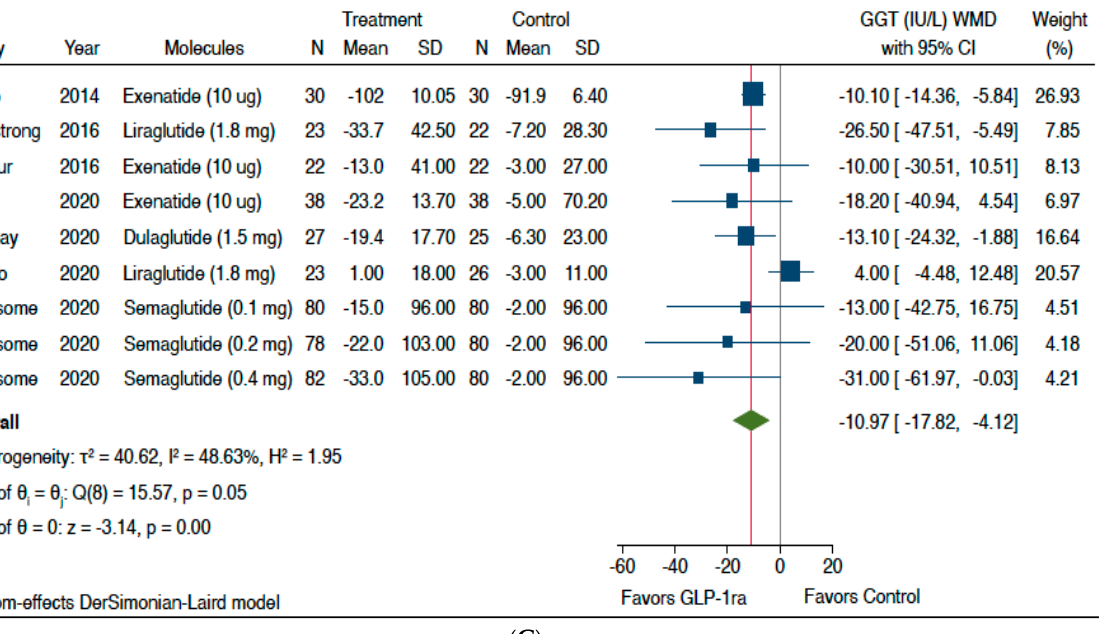
Figure 1. Forest plot and pooled estimates of the effects of different glucagon-like peptide-1 receptor agonists (GLP-1 Ras) on serum liver enzyme levels (i.e., serum alanine aminotransferase (ALT) ( n = 11 RCTs included, panel ( A )), aspartate aminotransferase (AST) ( n = 10 RCTs included, panel ( B )), and gamma-glutamyltransferase (GGT) ( n = 7 RCTs included, panel ( C ))) as compared with placebo or reference therapy. The pooled (green diamond) and individual effect sizes for all RCTs included were expressed as weighted mean difference (WMD) and 95% confidence intervals (CI).